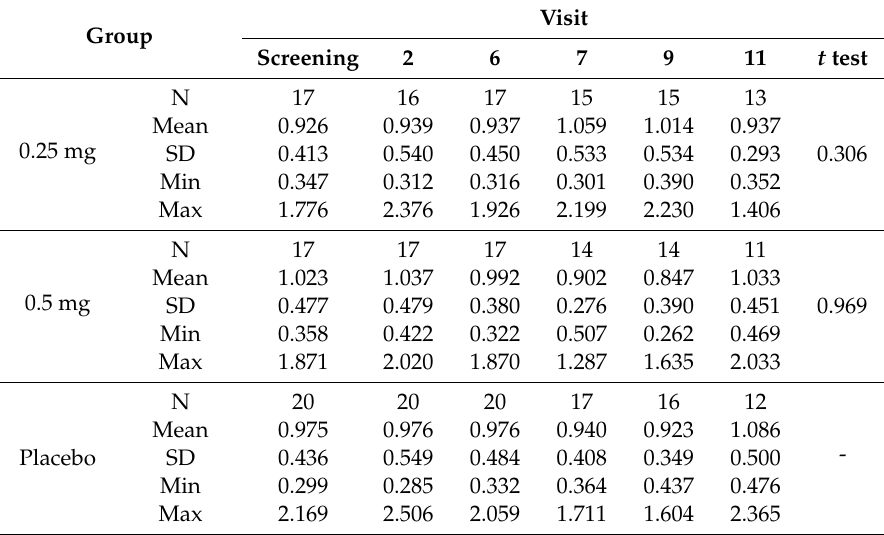
Table 5. Data on CD8 T cells number in trial participants at di ff erent visits (cells × 10 9 / L).